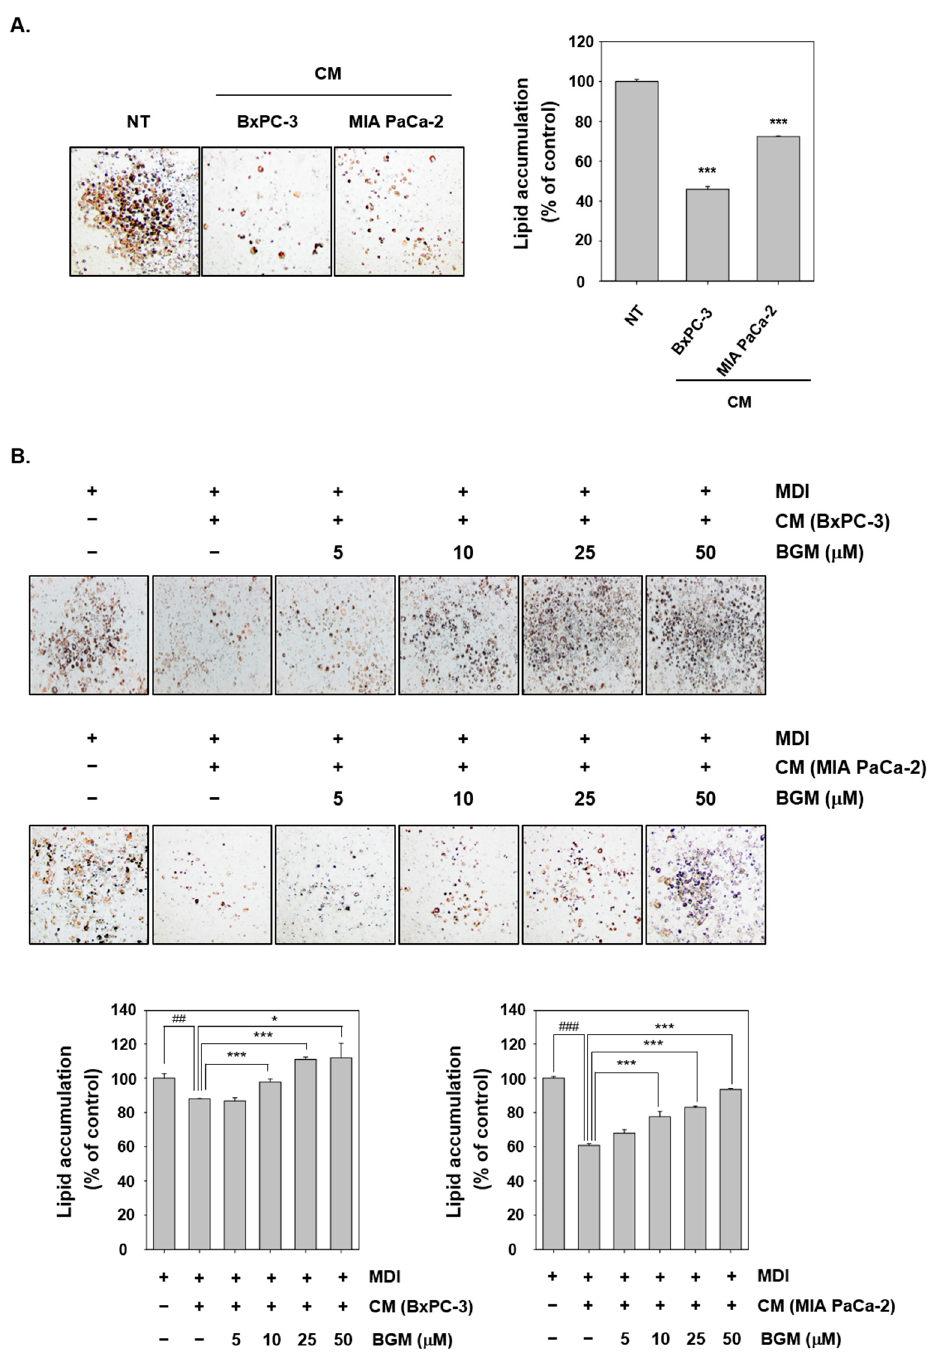
Figure 3. Suppressive actions of BGM on cancer cachexia could induce atrophy of adipocytes. ( A ) 3T3-L1 cells were incubated with MDI media for 3 days to cause differentiation into adipocytes and thereafter stimulated with BxPC-3 and MIA PaCa-2 CM for 2 days. The lipid droplets were observed by oil red staining, and lipid accumulation was measured by VARIOSKAN LUX (Thermo Fisher Scientific Inc, Waltham, MA, USA). ( B ) 3T3-L1 cells were differentiated into adipocytes and then treated with BGM (0, 5, 10, 25, and 50 µ M) along with BxPC-3 and MIA PaCa-2 CM for 2 days. Adipogenesis was observed by oil red staining and measured by VARIOSKAN LUX (Thermo Fisher Scientific Inc., Waltham, MA, USA). All the experiments were performed independently at least 3 times, and representative data are shown. Data represent means ± SD. ## p < 0.01 vs. NT, ### p < 0.001 vs. NT, * p < 0.05 vs. BGM, *** p < 0.001 vs. BGM.